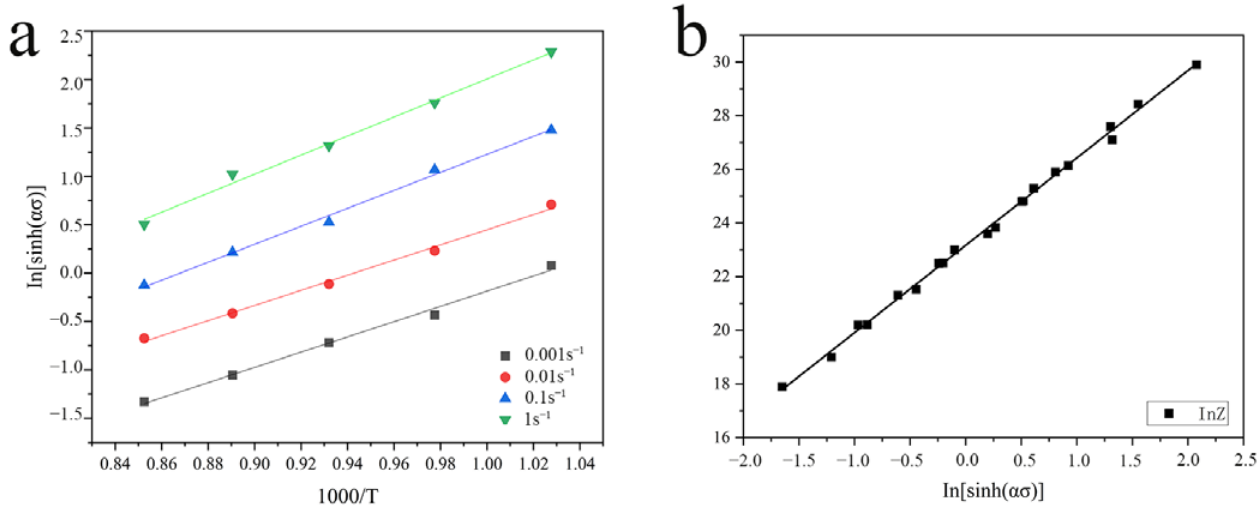
(cid:2) (cid:0) (cid:1)(cid:3) ∼ ασ p sinh ln 1000 and ( b ) ln Z ∼ ln T